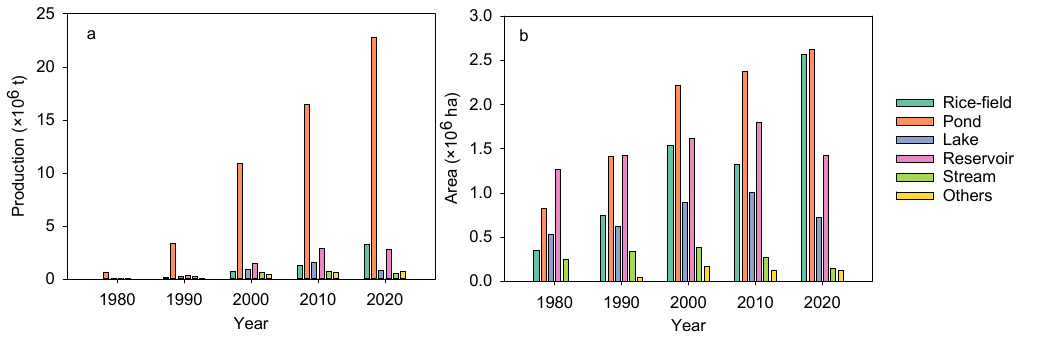
Figure 1. Comparison of freshwater aquaculture production ( a ) and area ( b ) between rice fields and other main water bodies in China [1].